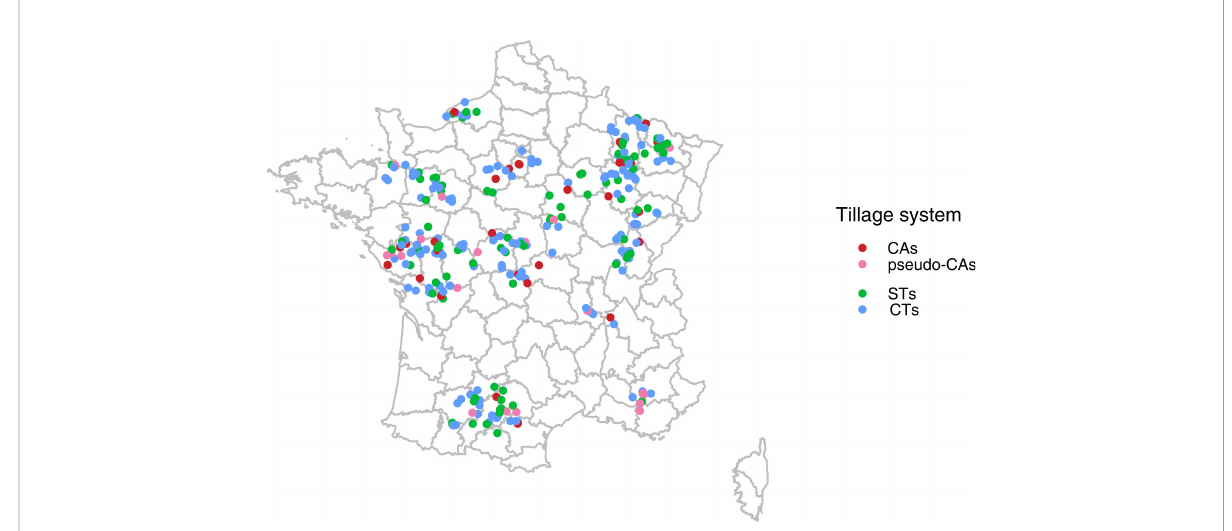
FIGURE 1 Geographical location of conservation agriculture (CAs, N=36), pseudo-CAs (N=19), and their reference conventional tillage (CTs, N=135) and super fi cial tillage (STs, N=90) based systems, all being part of the French DEPHY farm